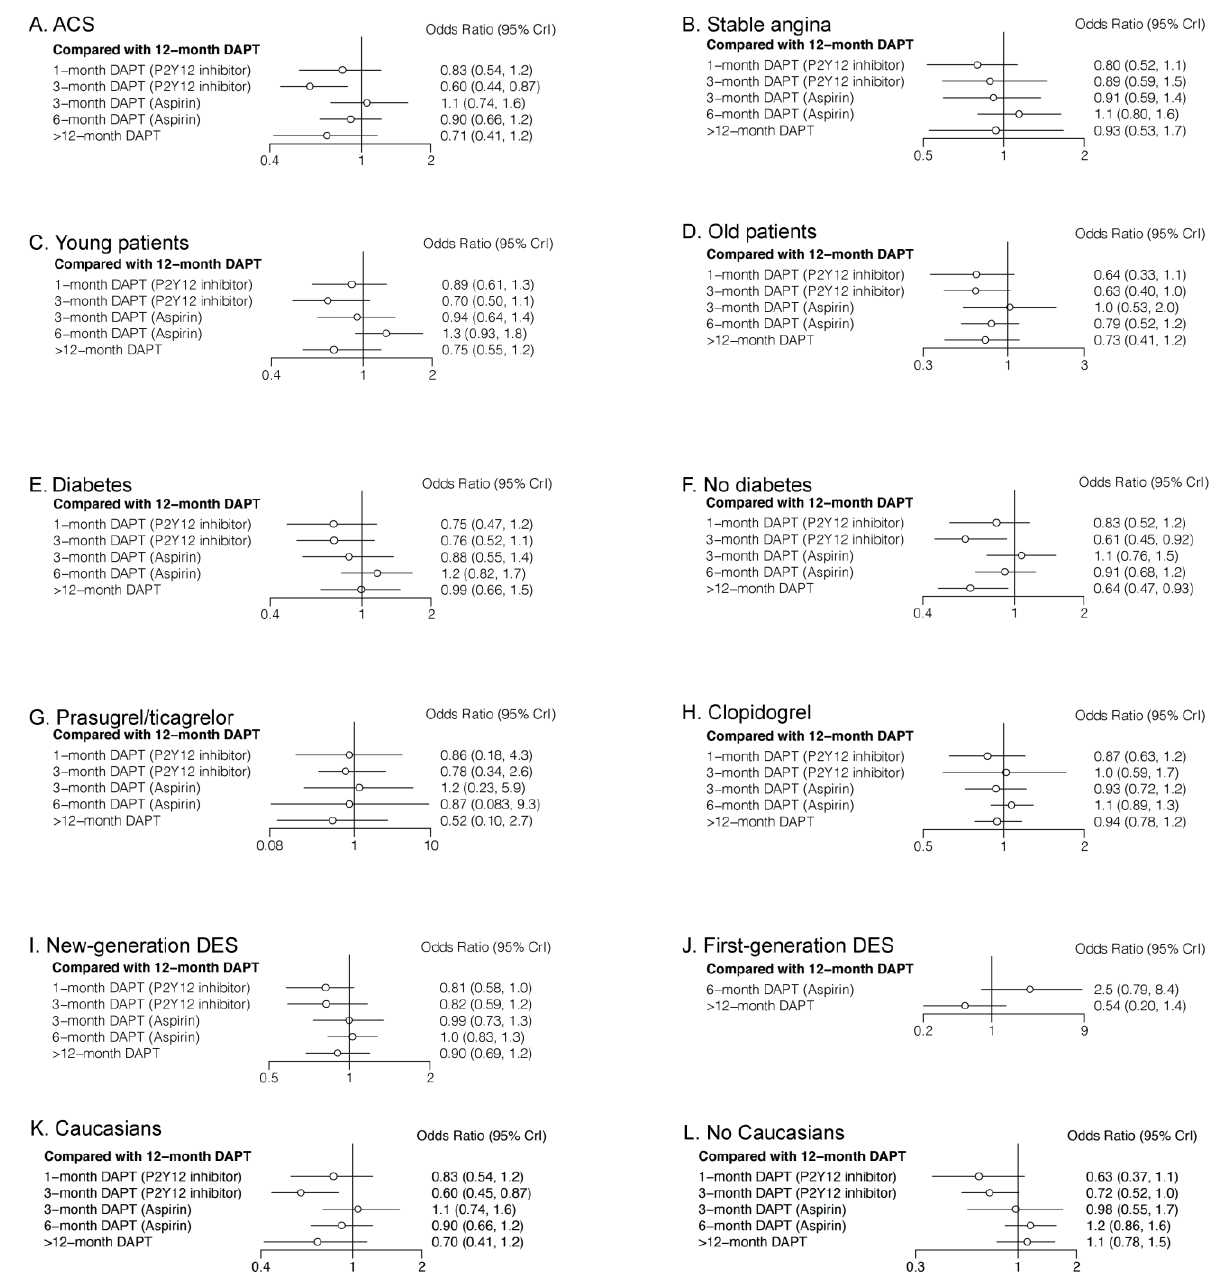
Figure 7. Comparision of Primary Outcomes in Different Patients.